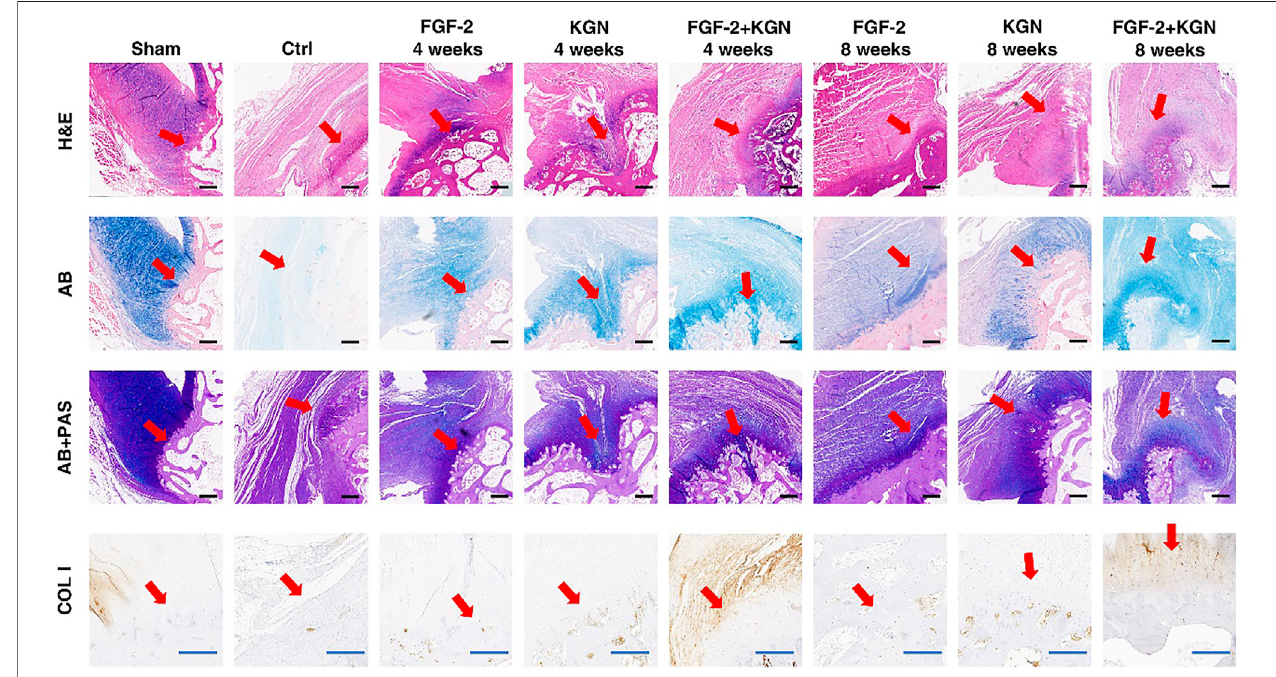
FIGURE 5 | H&E, AB, PAS staining, and type I collagen (COL I) immunohistochemical staining of the healing point of the tendon – bone (red arrows point to the tendon – bone interfaces; (scale bar: black-500 μ m (H&E, AB, and AB + PAS), blue-200 μ m (COL I)).